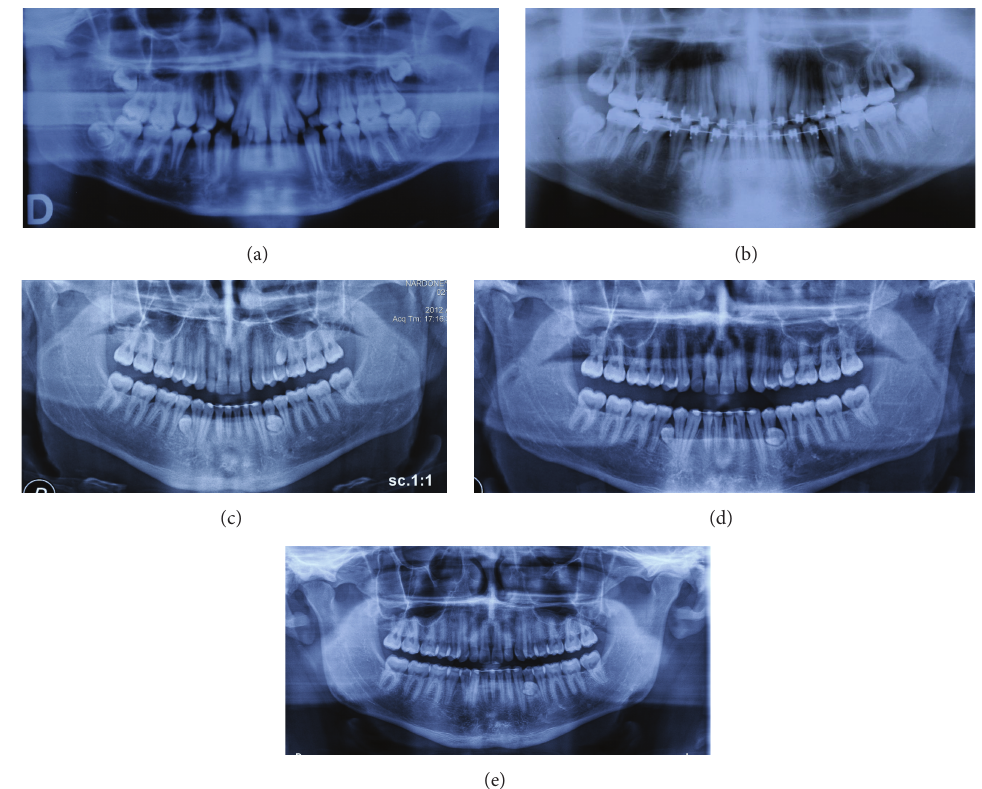
Figure 2: Case 2 radiography: before treatment 2006 (a), before rebonding, ST in regions 3.4–3.5, 4.4–4.5, and 2.5–2.6, 2009 (b), 3 years after debonding 2012 (c), 4 years after debonding 2013 (d), and after the extractions of ST in regions 4.4–4.5 and 2.5–2.6, 2015